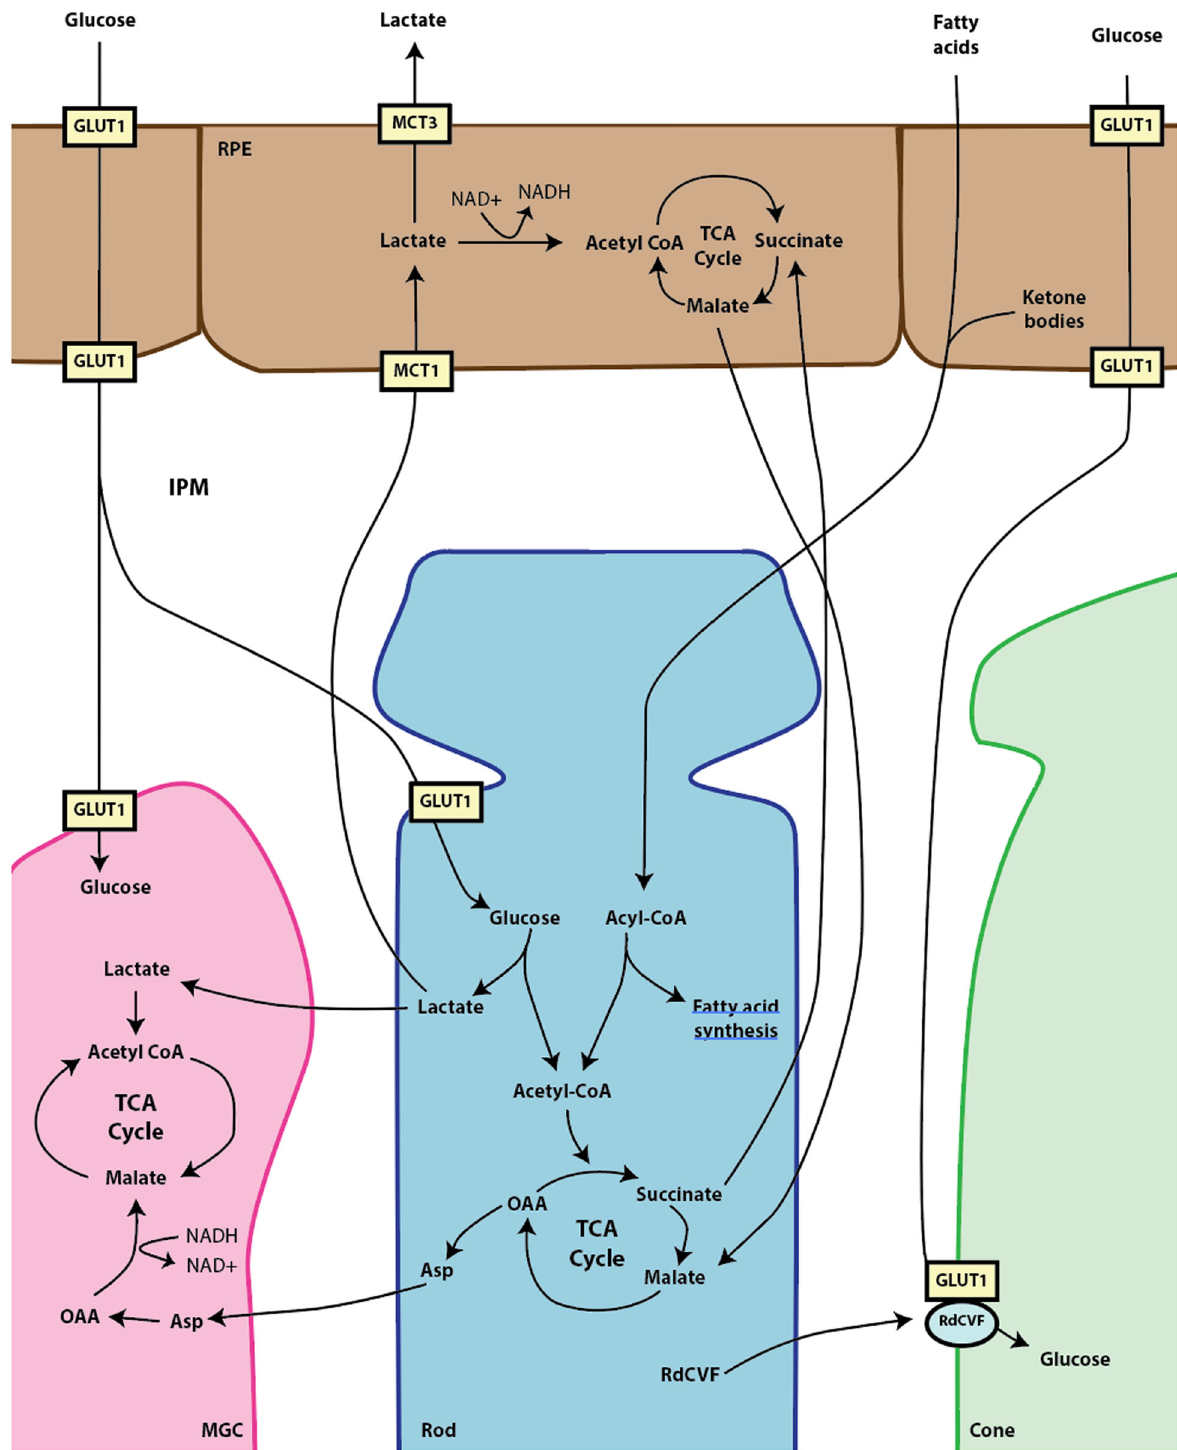
Fig. 3 The outer retinal metabolic ecosystem. Glucose from the choroid enters and exits the RPE (retinal pigment epithelium) via GLUT1 (glucose transporter 1) to enter MGCs (Müller glial cells) and rod and cone photoreceptors via GLUT1. Rods secrete RdCVF (rod-derived cone viability factor), which complexes with GLUT1 in cones and enhances glucose entry. Glucose then either undergoes aerobic glycolysis to produce lactate or enters the TCA cycle to produce metabolic intermediates like aspartate and succinate. Lactate enters the interphotoreceptor matrix (IPM), proceeds to the nearby MGC and RPE via MCT1 (monocarboxylate transporter 1) and is either used as a substrate for the TCA cycle or exit the RPE into the choroid via MCT3 (monocarboxylate transporter 3). To regenerate the nicotinamide adenine dinucleotide (NAD + ) necessary for lactate-driven respiration, aspartate is converted to OAA (oxaloacetate) and subsequently, malate to enter the TCA cycle in the MGCs. In PRs, fumarate can also be reduced to succinate, transported to RPE, and enter the TCA cycle. In return, RPE sends malate back to PRs. Additionally, fatty acids from the choroid and ketone bodies from the RPE enter photoreceptors, where they are converted to acyl-CoA and enter the TCA cycle or undergo fatty acid